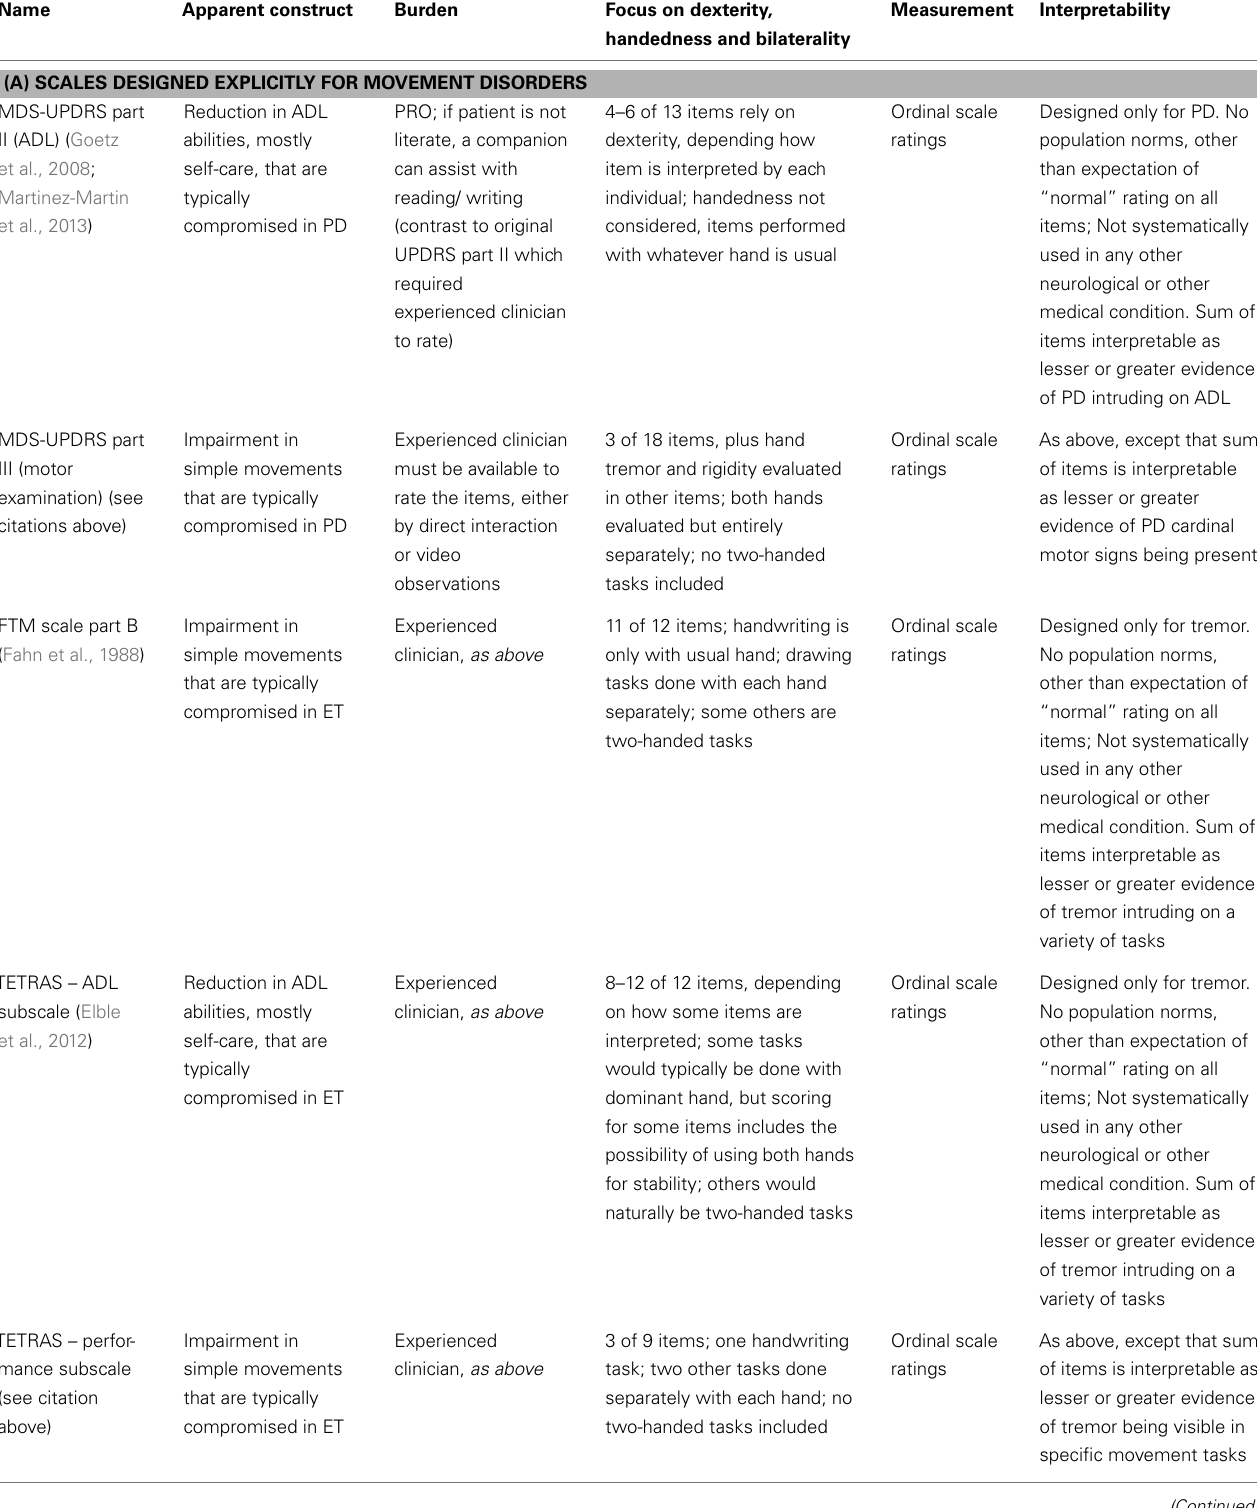
Table 2 | Selected measures related to hand